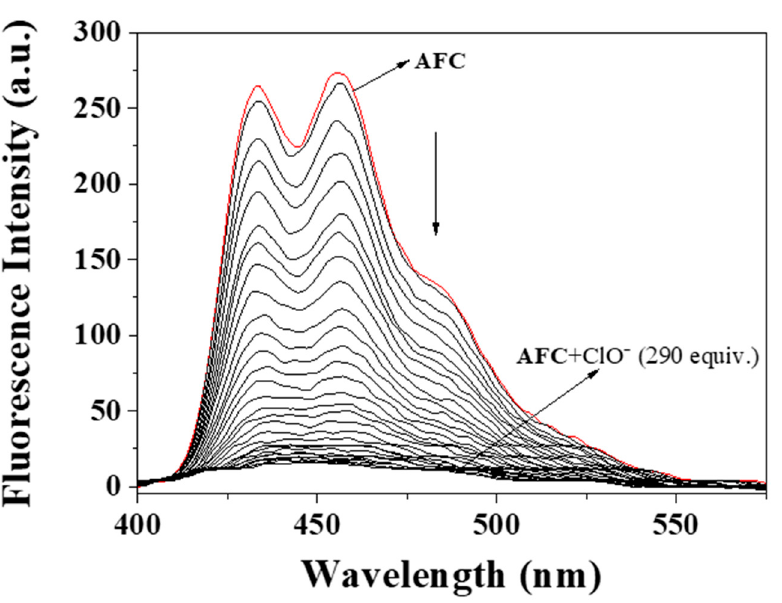
Figure 2. Fluorescent change of AFC (1 × 10 − 5 M) with different amounts of ClO − (from 0 to 290 equivalents).